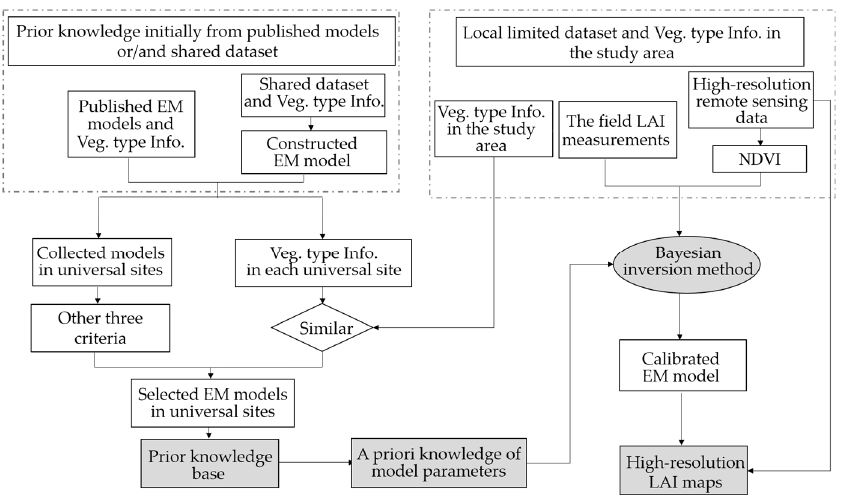
Figure 2. Flowchart of a prior knowledge-based (PKB) method to derivate high-resolution LAI maps with limited filed measurements (the EM model represents the semi-empirical model and “Veg. type Info.” represents vegetation type information).